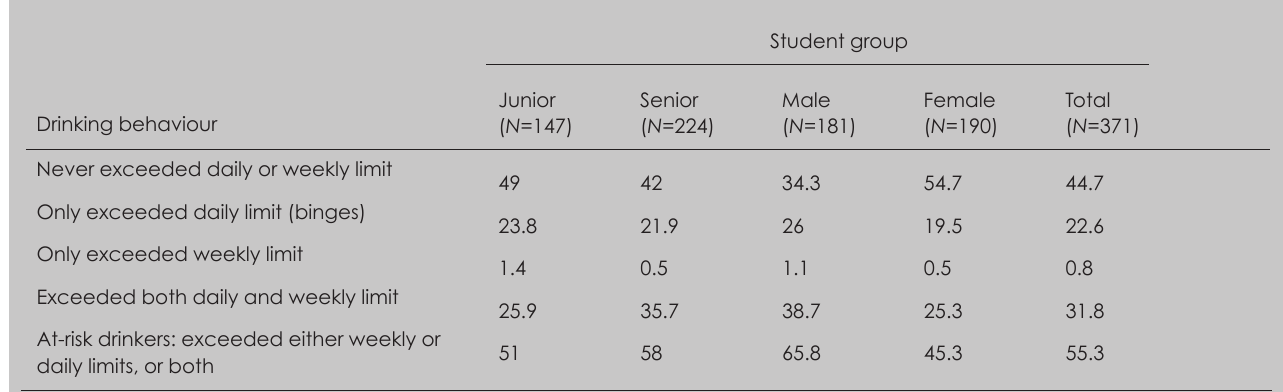
Table II. Students’ alcohol use in the preceding year according to criteria for at-risk drinking (%)